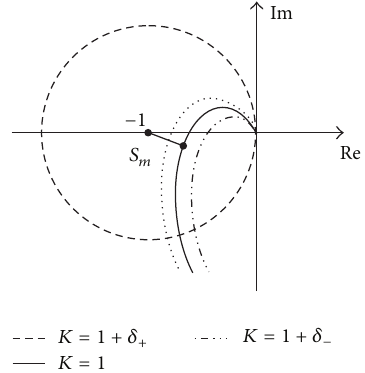
Figure 10: Nyquist plot with the stability margin.